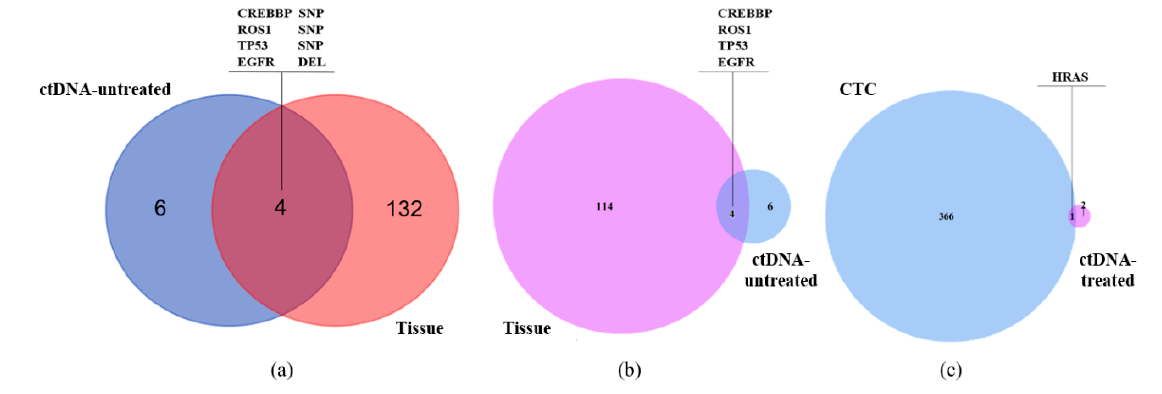
Figure 6. Common SNVs, InDels and mutated genes in liver biopsy tissue, ctDNA and single CTC samples. ( a , b ) Common mutation sites and related genes in ctDNA and liver biopsy tissue samples before treatment (S124 and S145). ( c ) Common gene mutation in single CTC and ctDNA sample after treatment (S094 and S063). SNP: single nucleotide polymorphism; DEL: deletion.